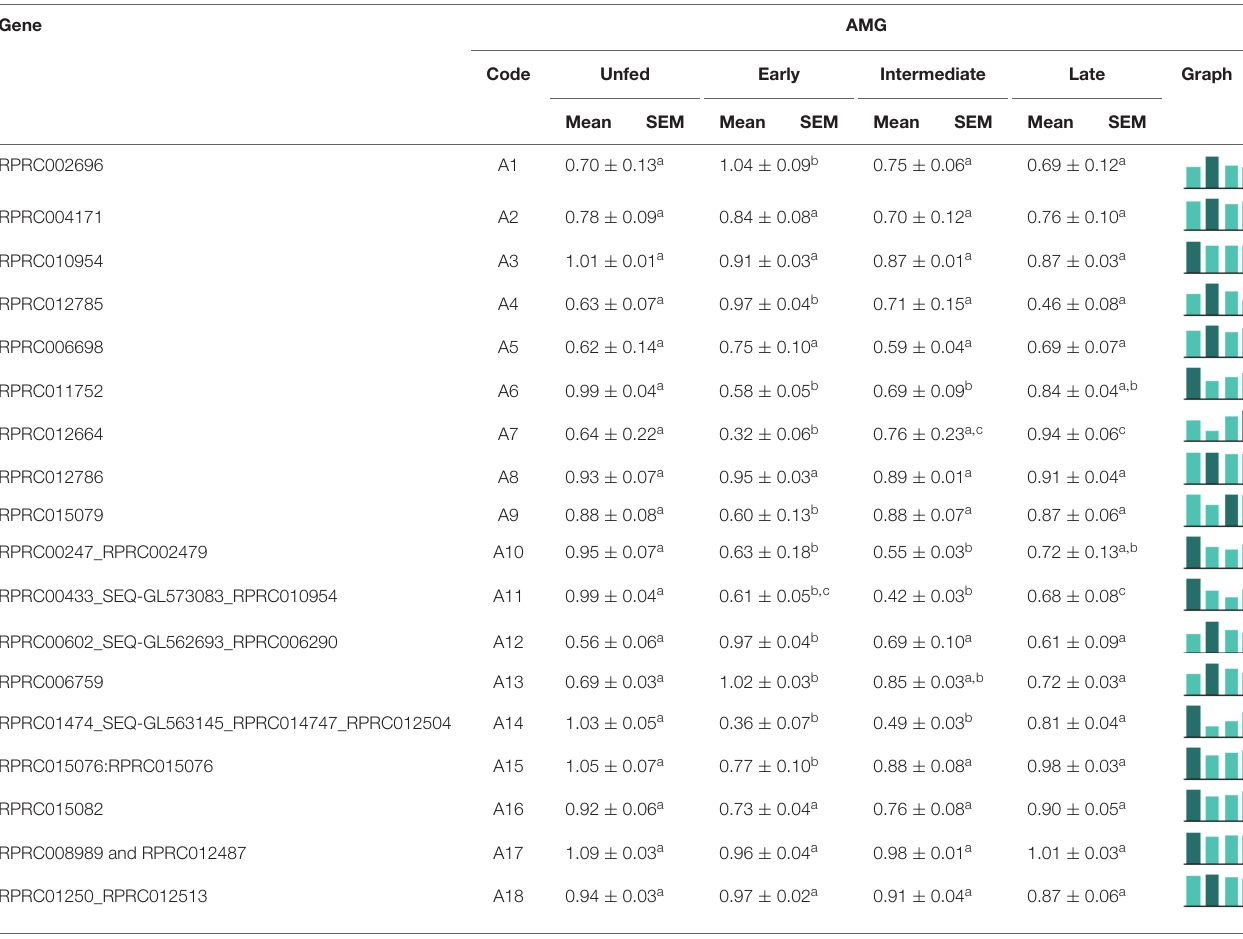
Figures are means ± SEM from three amplification determinations using cDNA pool preparations of six insect samples each. In a dataset, groups with the same superscript letter are not significantly different (p ≥ 0.05). In the miniature graphs, differently colored bars highlight the highest expression levels. Statistical analysis consisted of ordinary two-way ANOVA with Tukey’s multiple-comparisons